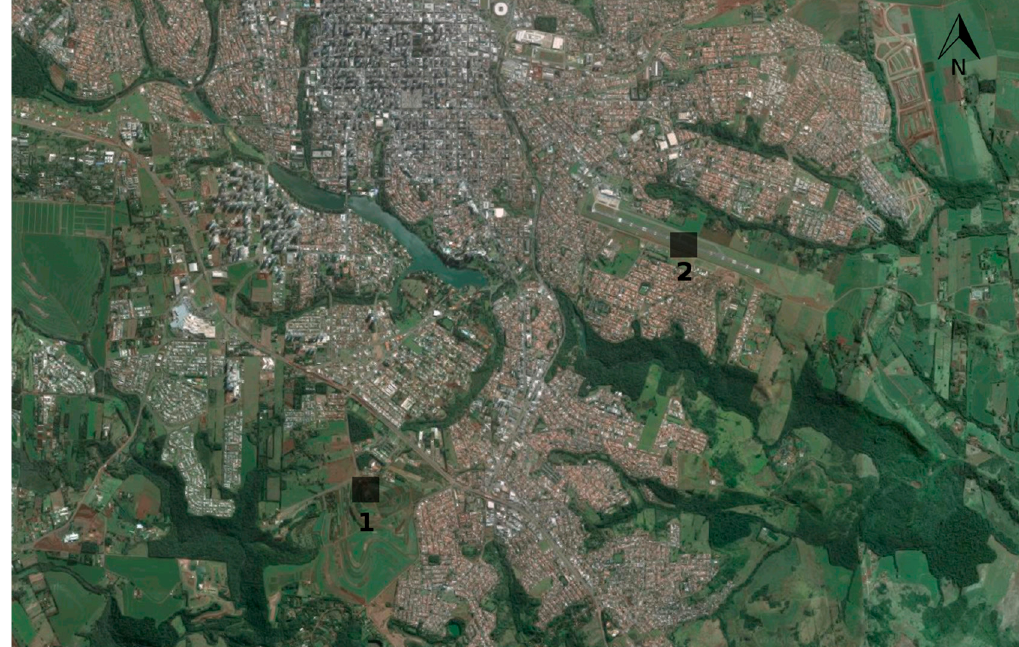
Figure 3. Localization of the meteorological station from the city of Londrina. Number 1 is the SIMEPAR station, while number 2 is the METAR